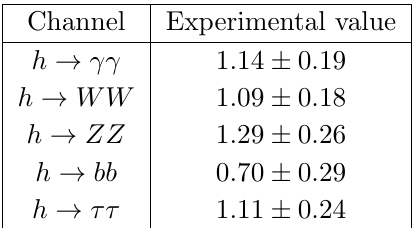
Table 6 . Tree level couplings of the Higgs bosons to quarks and vector bosons normalised to the SM couplings. The gray values correspond to the decoupling limit where M A (cid:29) M Z .